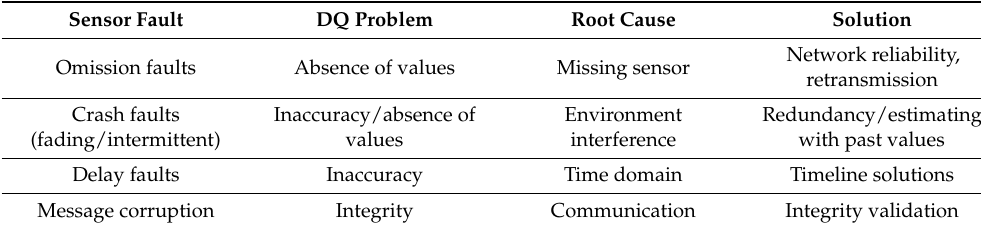
Table 3. SCP Network Errors.